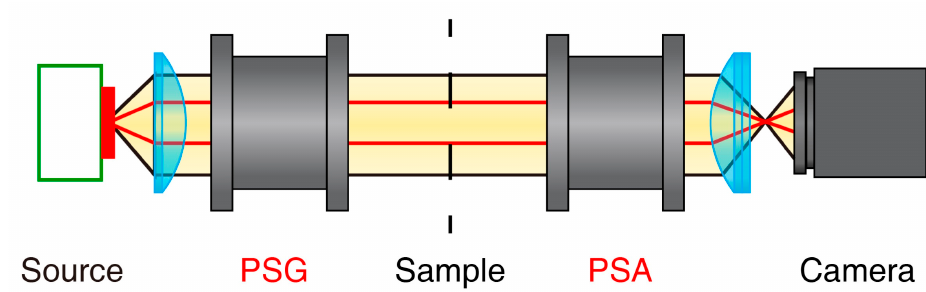
Figure 3. Schematic of Mueller matrix polarimeter.